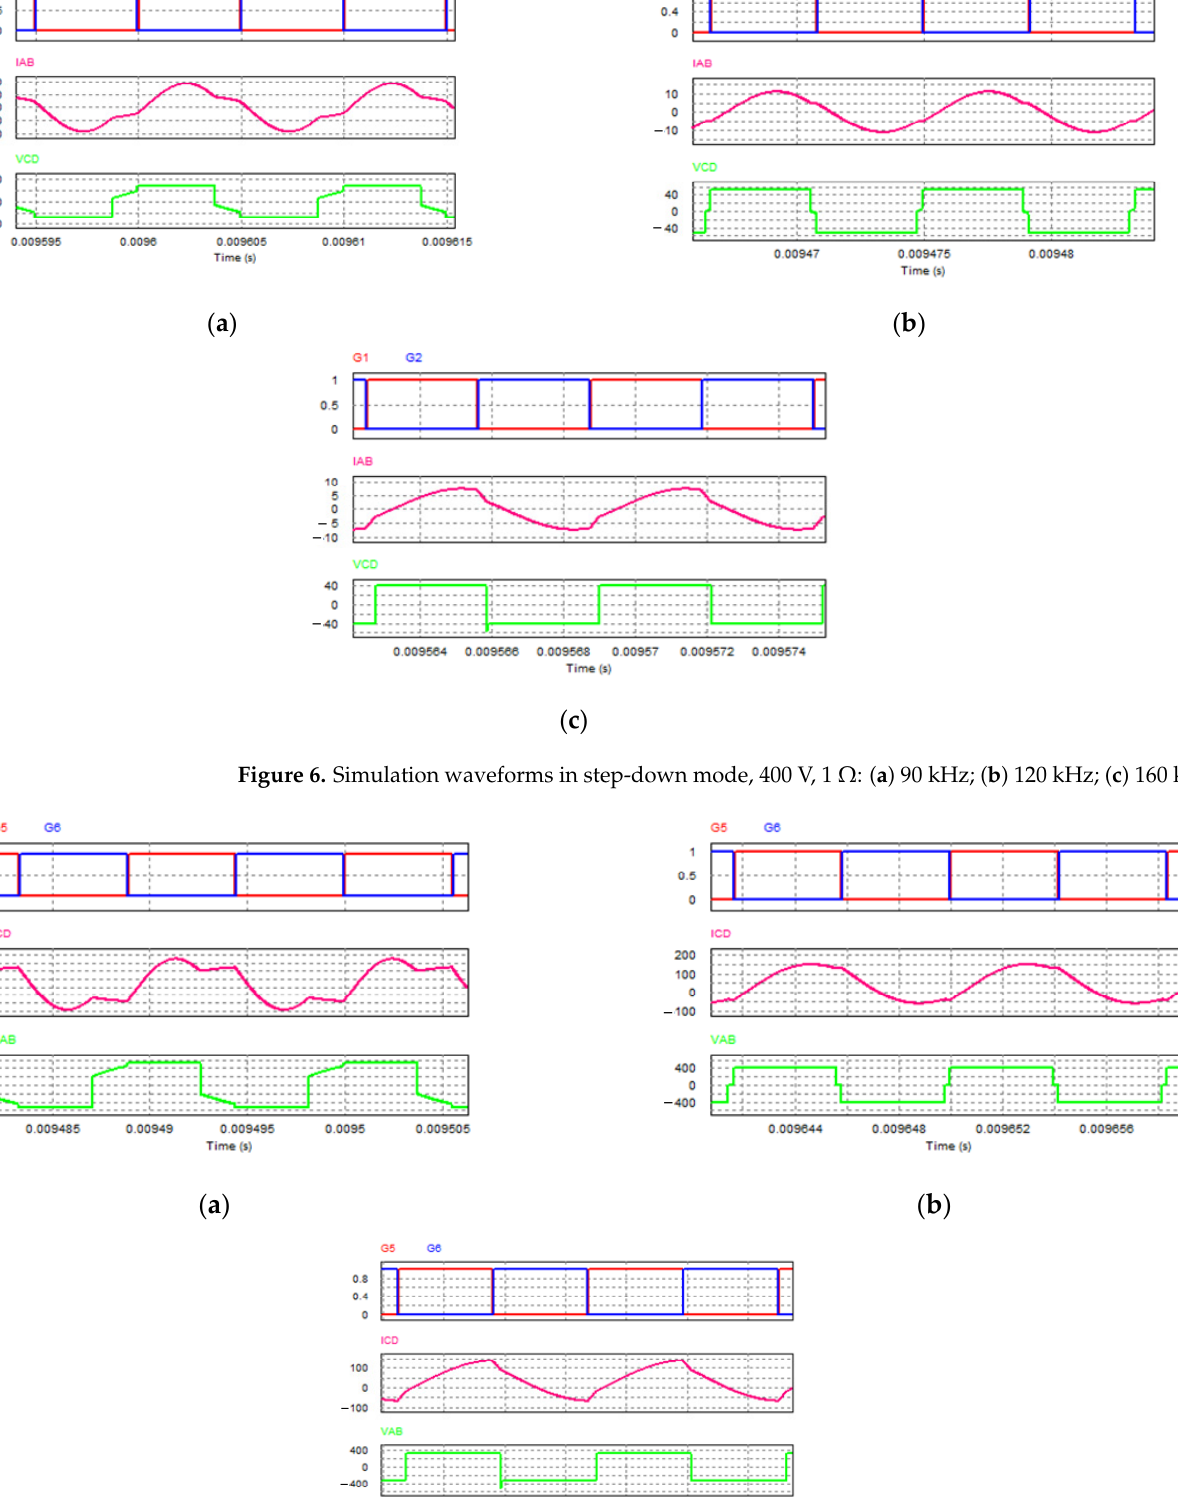
Figure 5. Simulation model for DHC-LT BDC (The symbols of “*” are dotted terminals of T 2 ).